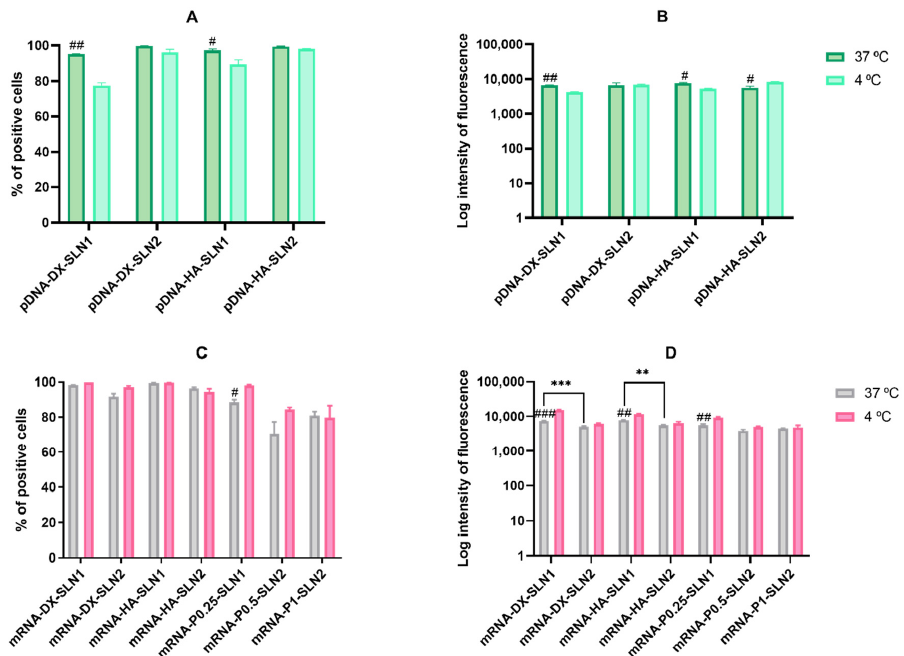
Figure 5. Flow cytometry analysis of cellular uptake of vectors using Nile Red–labeled pDNA- and mRNA-SLNs in ARPE-19 cells at 37 and 4 ◦ C. Data are expressed as mean ± standard deviation; n = 3. ( A ) Percentage of Nile Red positive ARPE-19 cells 2 h after the treatment with pDNA vectors. ( B ) Intensity of fluorescence of Nile Red positive ARPE-19 cells 2 h after the treatment with pDNA vectors. ( C ) Percentage of Nile Red positive ARPE-19 cells 2 h after the treatment with mRNA vectors. ( D ) Intensity of fluorescence of Nile Red positive ARPE-19 cells 2 h after the treatment with mRNA vectors. # p < 0.05 with respect to the same vector at 4 ◦ C. ## p < 0.01 with respect to the same vector at 4 ◦ C. ### p < 0.001 with respect to the same vector at 4 ◦ C. ** p < 0.01 with respect to the other